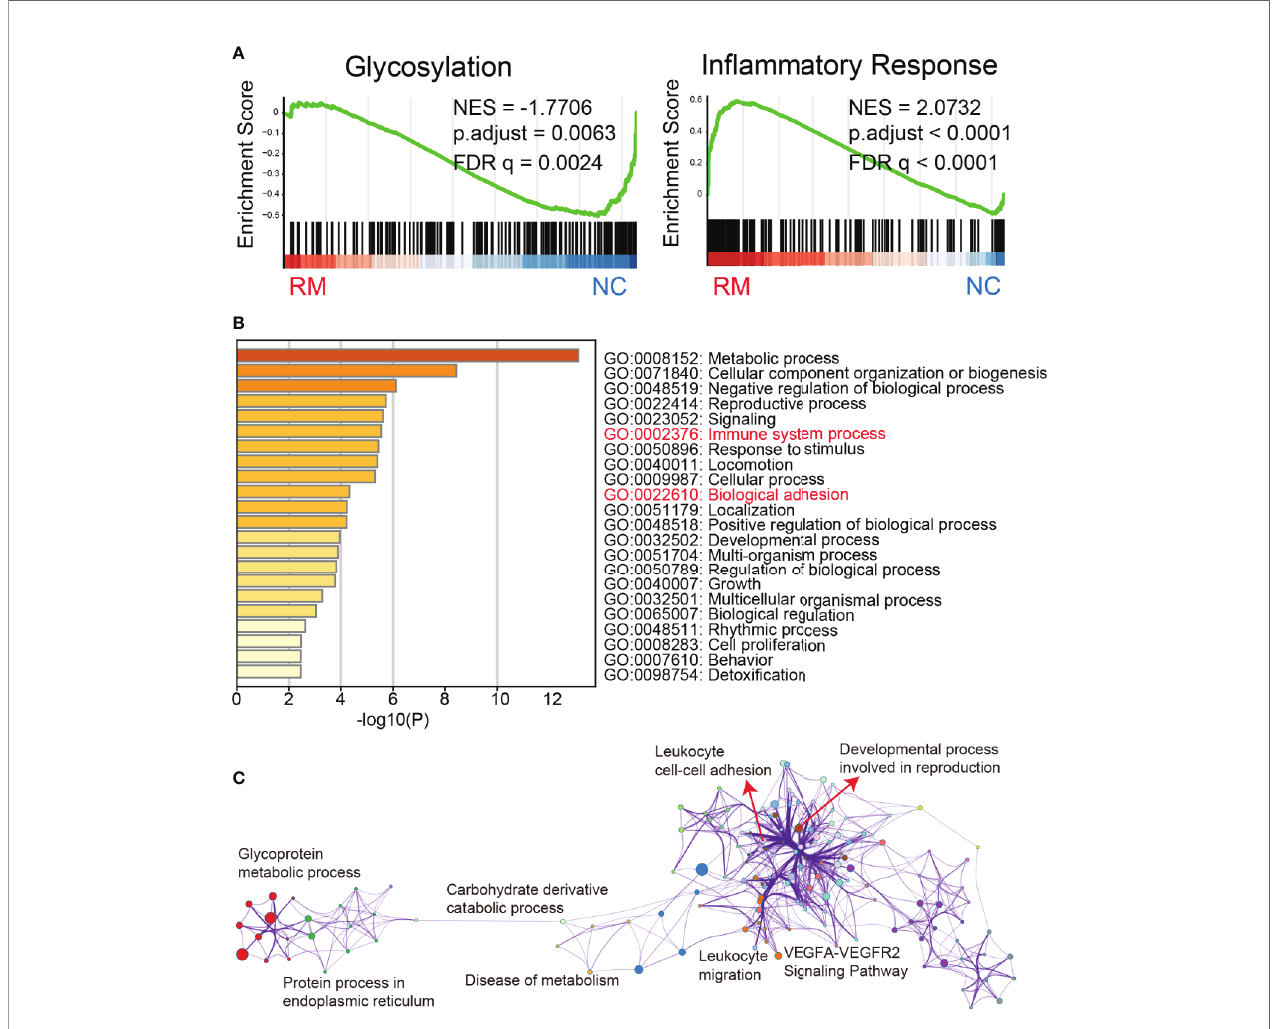
FIGURE 2 | Gene expression and network analysis. (A) Gene Set Enrichment Analysis of glycosylation and in fl ammatory response related genes in the RM patients from previously published data set GSE76862. Shown are the graphic enrichment of two gene sets (GO_GLYCOSYLATION, GO:0070085 and HALLMARK_INFLAMMATORY_RESPONSE, M5932) in RM patients (left, red) compared with healthy controls (right, blue). NES, Normalized enrichment score; FDR, False discovery rate. (B) Metascape results obtained with the differentially downregulated GO_GLYCOSYLATION genes con fi rm that Immune system process and Biological adhesion are signi fi cantly related to the aberrant glycosylation status in RM. (C) Network visualization of pathways was enriched also with differentially downregulated GO_GLYCOSYLATION genes in RM by performing Metascape, different colors represent different GO term